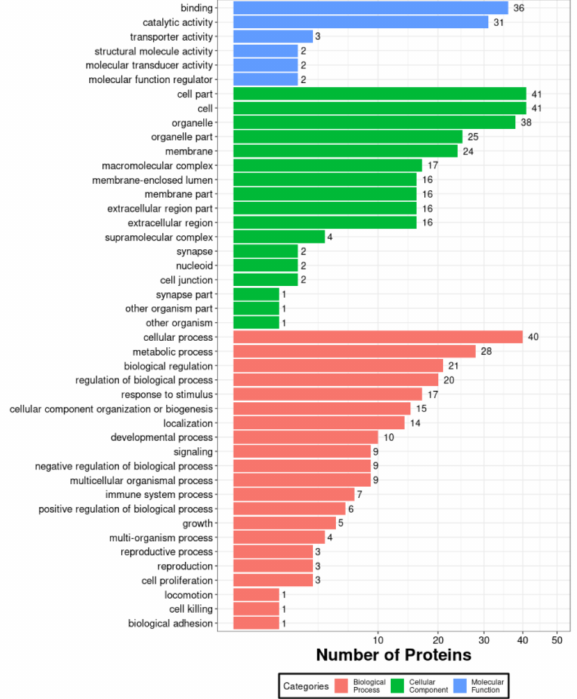
Figure 3. GO enrichment analysis of the top 66 down-regulated proteins. The distribution is divided into three categories: biological process, molecular function, and cellular component in 66 down regulated proteins. The x -axis indicates the number of proteins and the y -axis indicates different GO